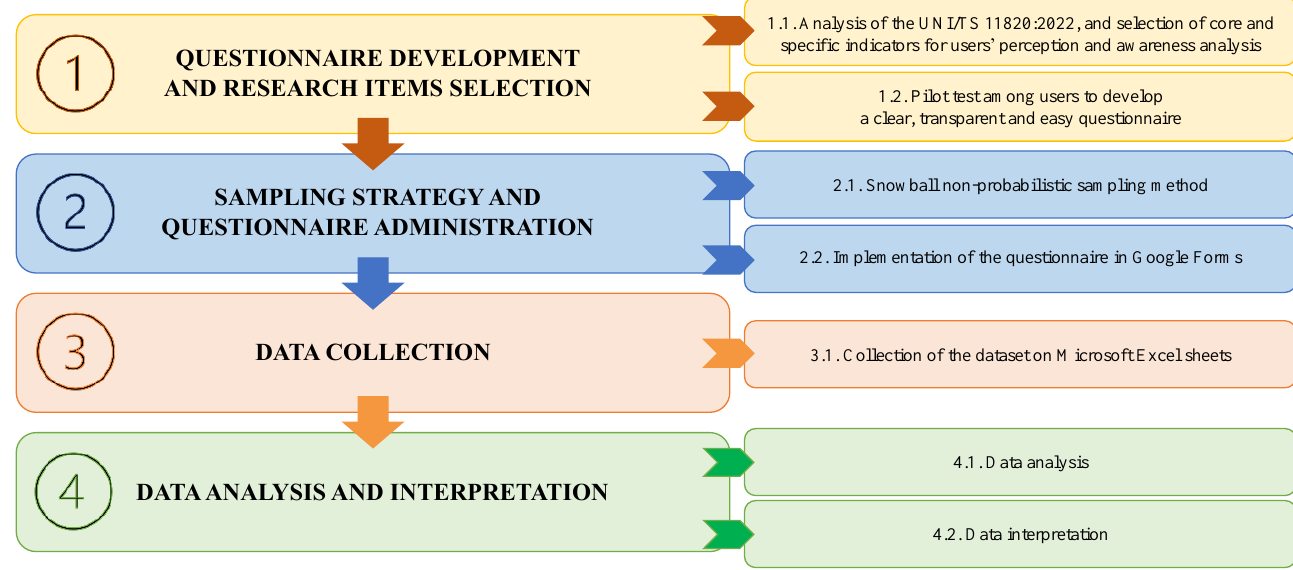
Figure 1. Research framework. Source: personal elaboration by the authors.